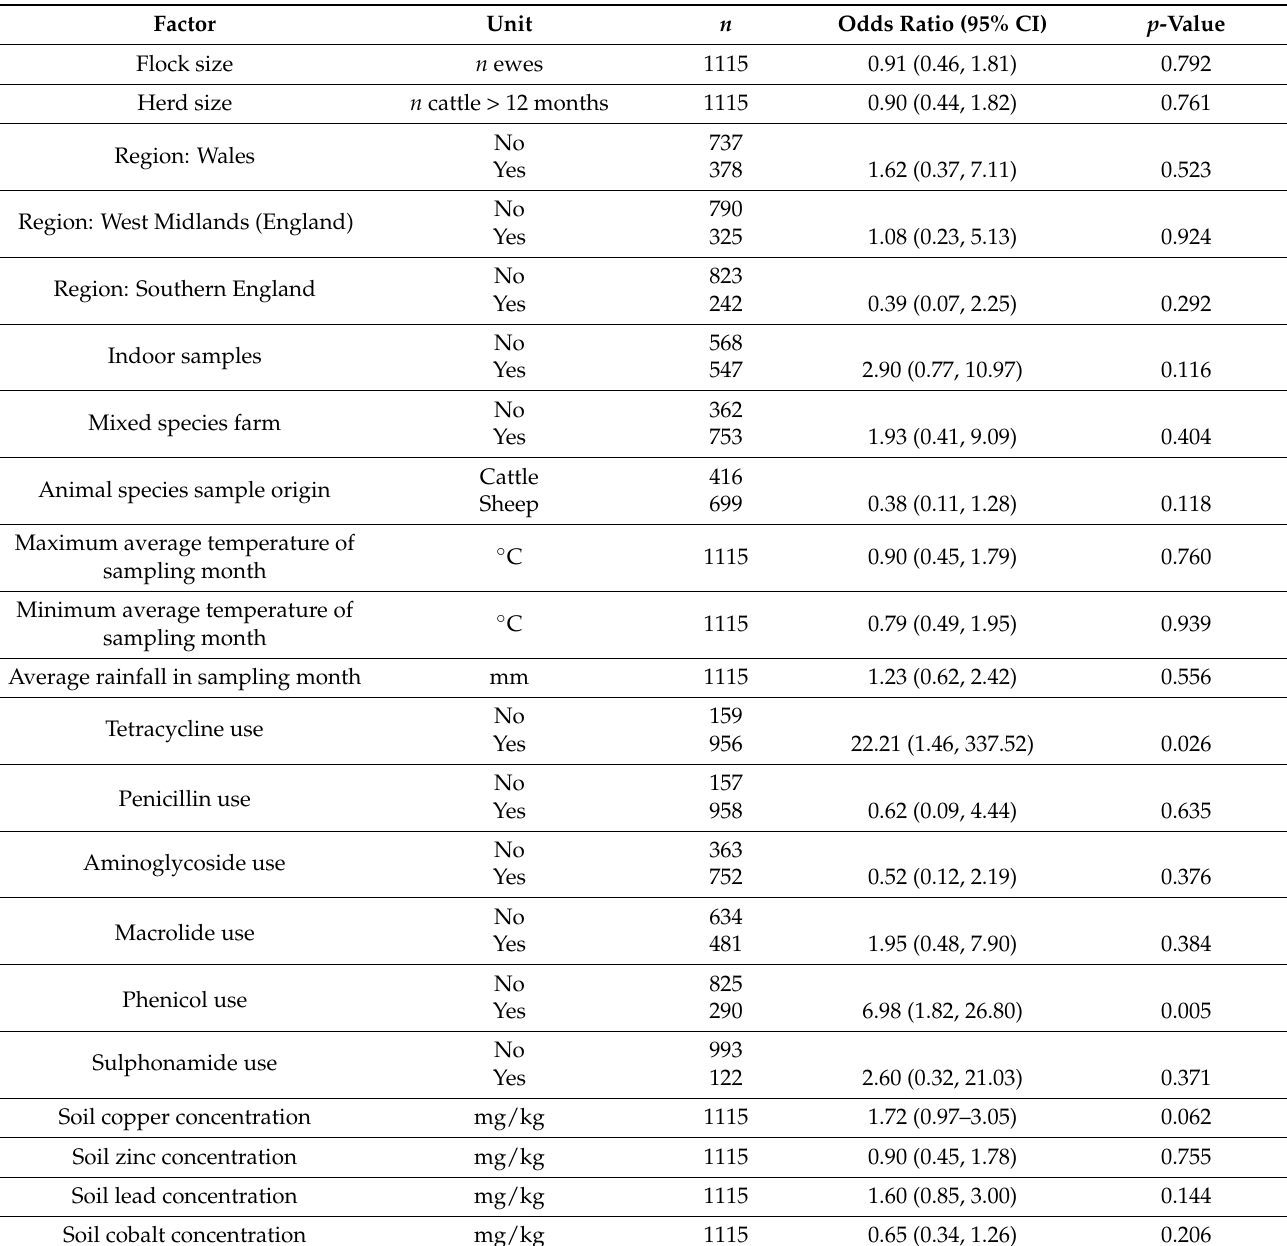
Table 6. Univariable multilevel logistic regression analysis for risk factors associated with E. coli defined as non-wild type for tetracycline.